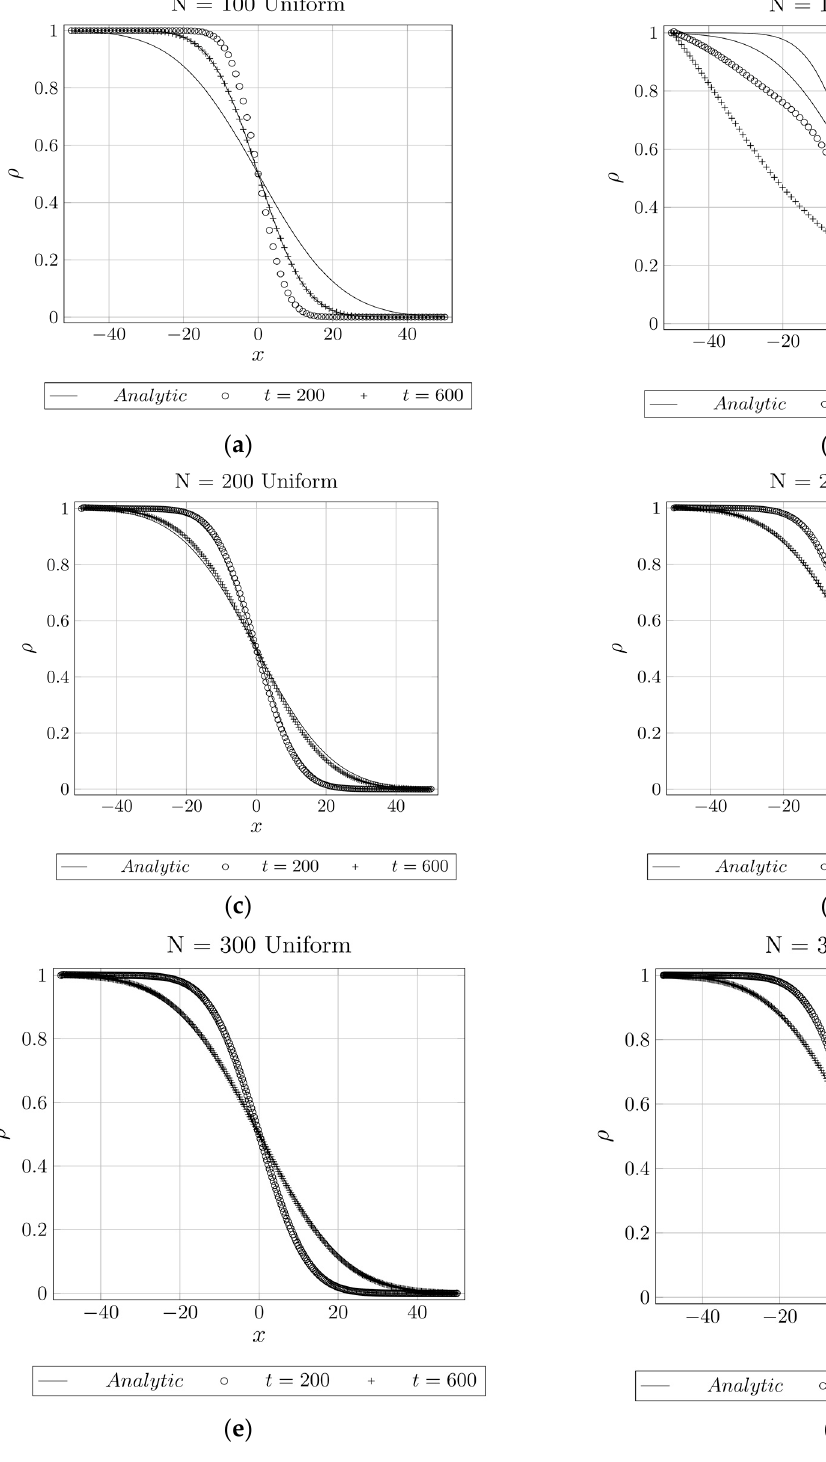
Figure 3. Diffusion problem solved by LBM combined with RBF interpolation. ( a , c , e ) have a uniform mesh with 100, 200, and 300 points, respectively, while ( b , d , f ) have a stretched mesh with 100, 200, and 300 points, respectively.